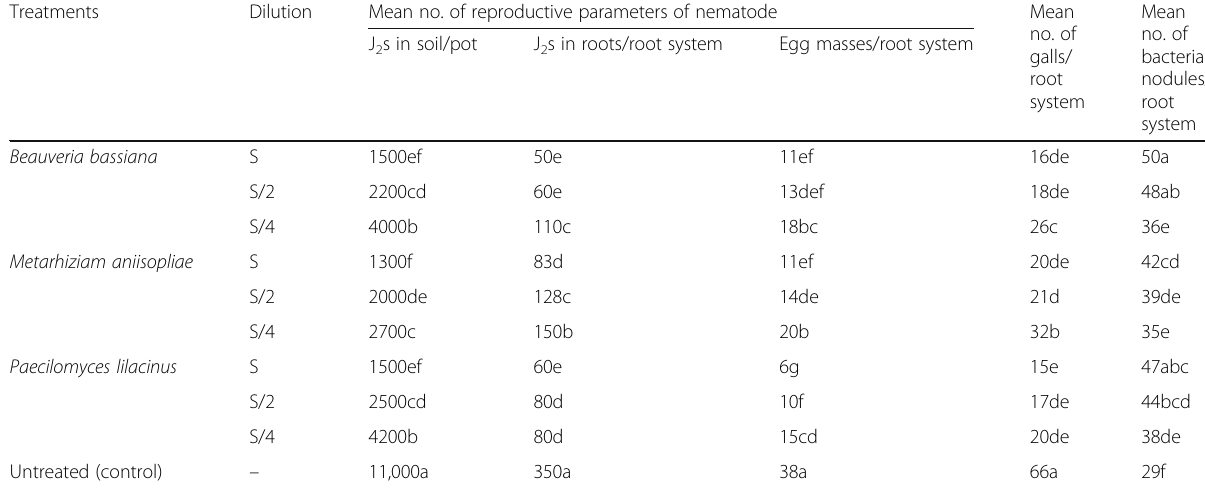
Table 4 Number of the root-knot nematode, Meloidogyne incognita infecting cowpea, number of gall and number of bacterial nodules as affected by three culture filtrates from Beauveria bassiana , Metarhiziam aniisopliae , and Paecilomyces lilacinus Treatments Dilution Mean no. of reproductive parameters of nematode